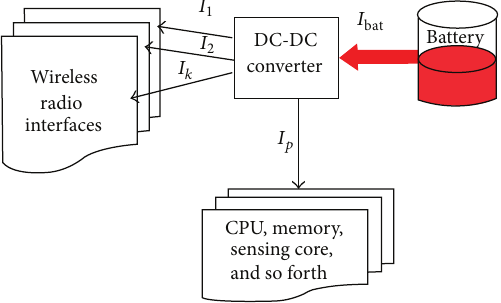
Figure 4: System level block of smart batteries